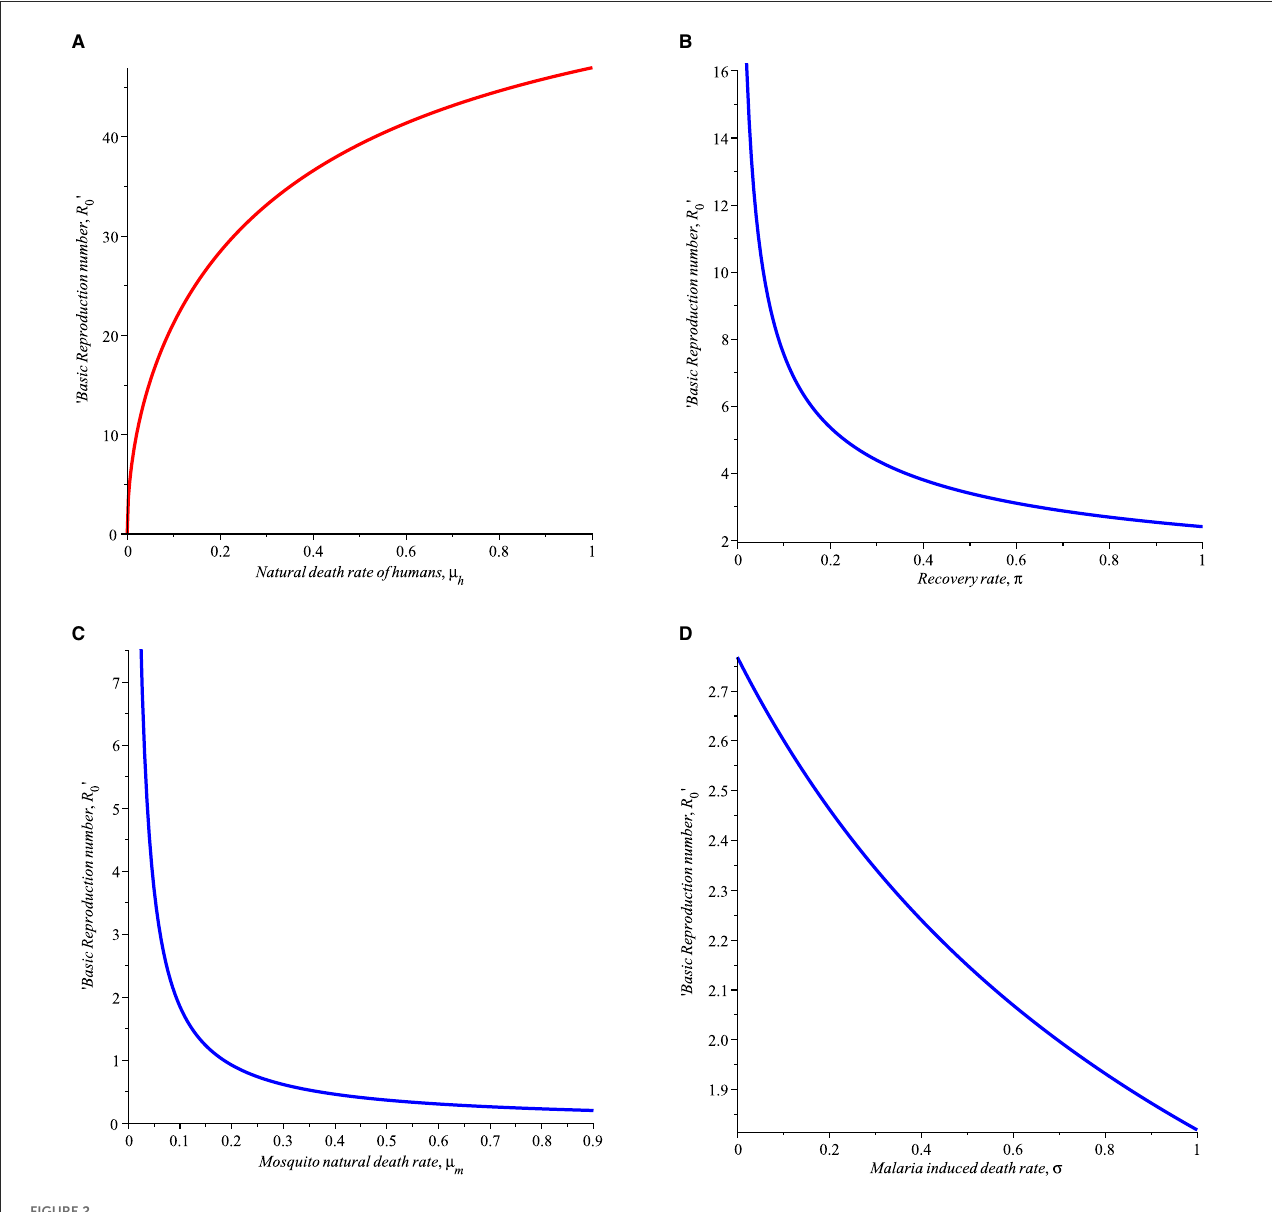
FIGURE2 Simulation showing the impact of (A) natural death rate of humans (B) human recovery rate from malaria ( π ), (C) mortality rate of mosquitoes ( µ m ), (D) malaria induced death rate ( σ ) with parameters set given in Table 1.